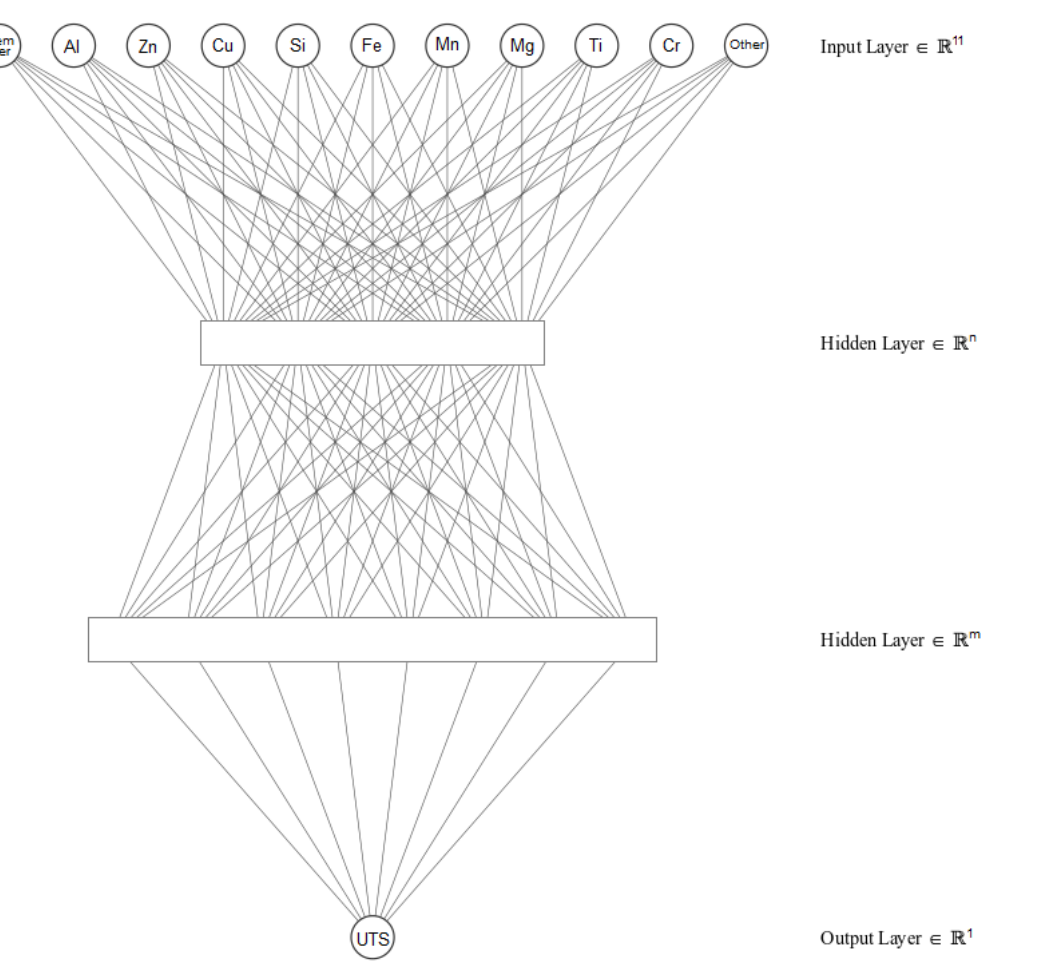
Figure 2. Multilayer artificial neural network